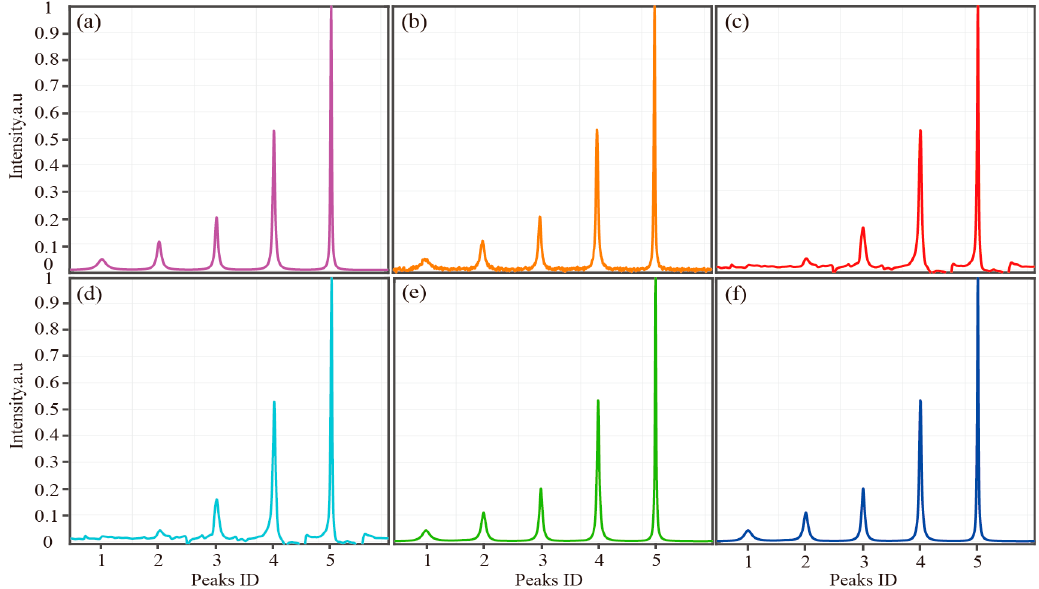
Figure 2. Reconstructed synthetic 1D spectra with five peaks from 6% acquired data. ( a ) The fully sampled spectrum; ( b ) the noisy fully sampled spectrum; ( c – f ) reconstructed spectra using the low-rank Hankel matrix (LRHM), LRHM with matrix factorization (LRHMF), self-learning subspace (SLS) and SLSMF, respectively. Table 4. Statistics of peaks correlations and standard deviations.